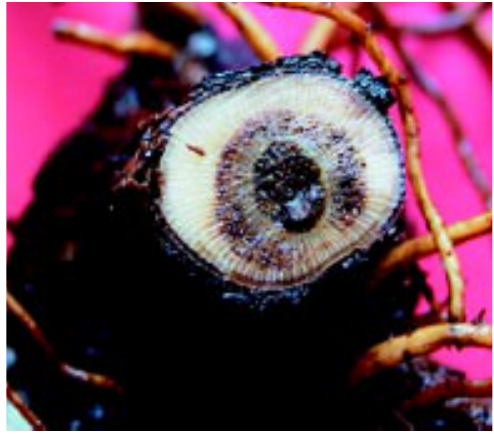
Fig. 1. Cross-section through the basal end of a rootstock stem of 1-year-old naturally infected grapevine (Richter 110) showing internal symptoms of Petri